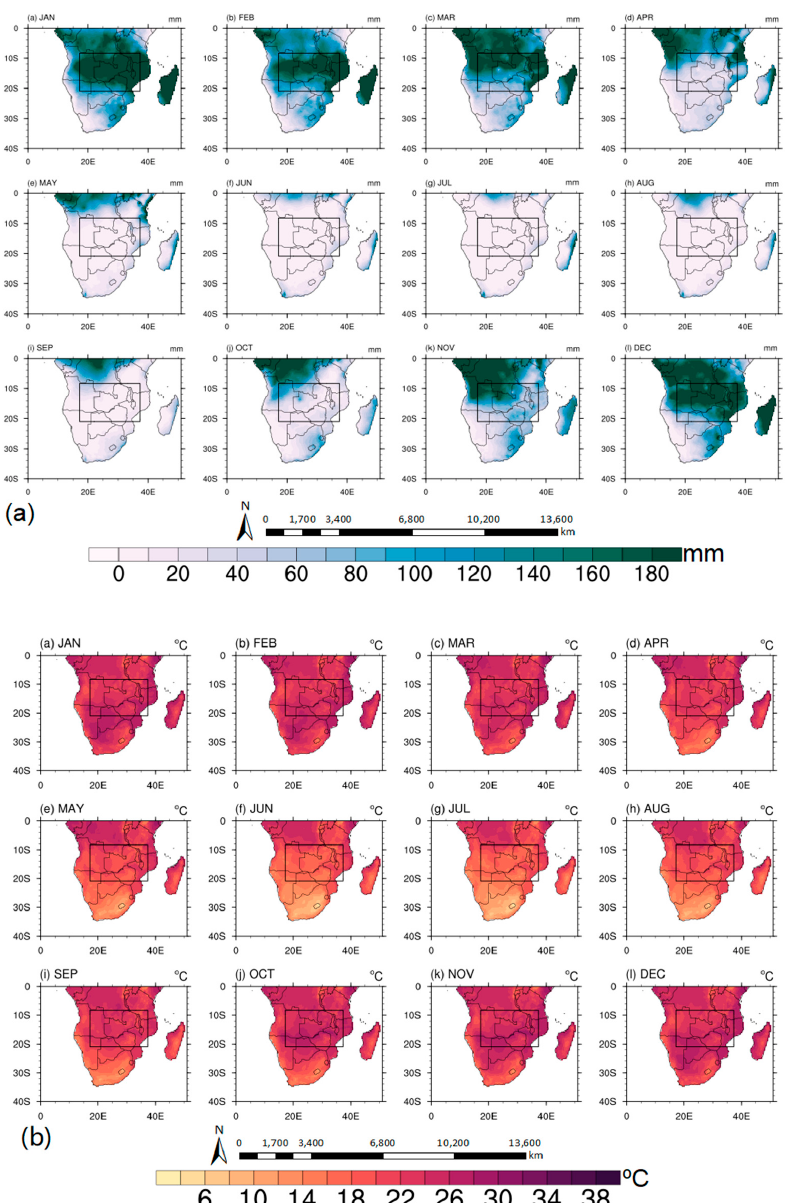
Figure 2. Spatial distribution of ( a ) monthly rainfall and ( b ) monthly surface air temperature over the ZRB from January to December, averaged over 1986–2015 (30-year period). The black boxes indicate the ZRB. Gridded observational temperature and precipitation dataset [47] derived from East Anglia’s Climate Research Unite was used to plot this figure.